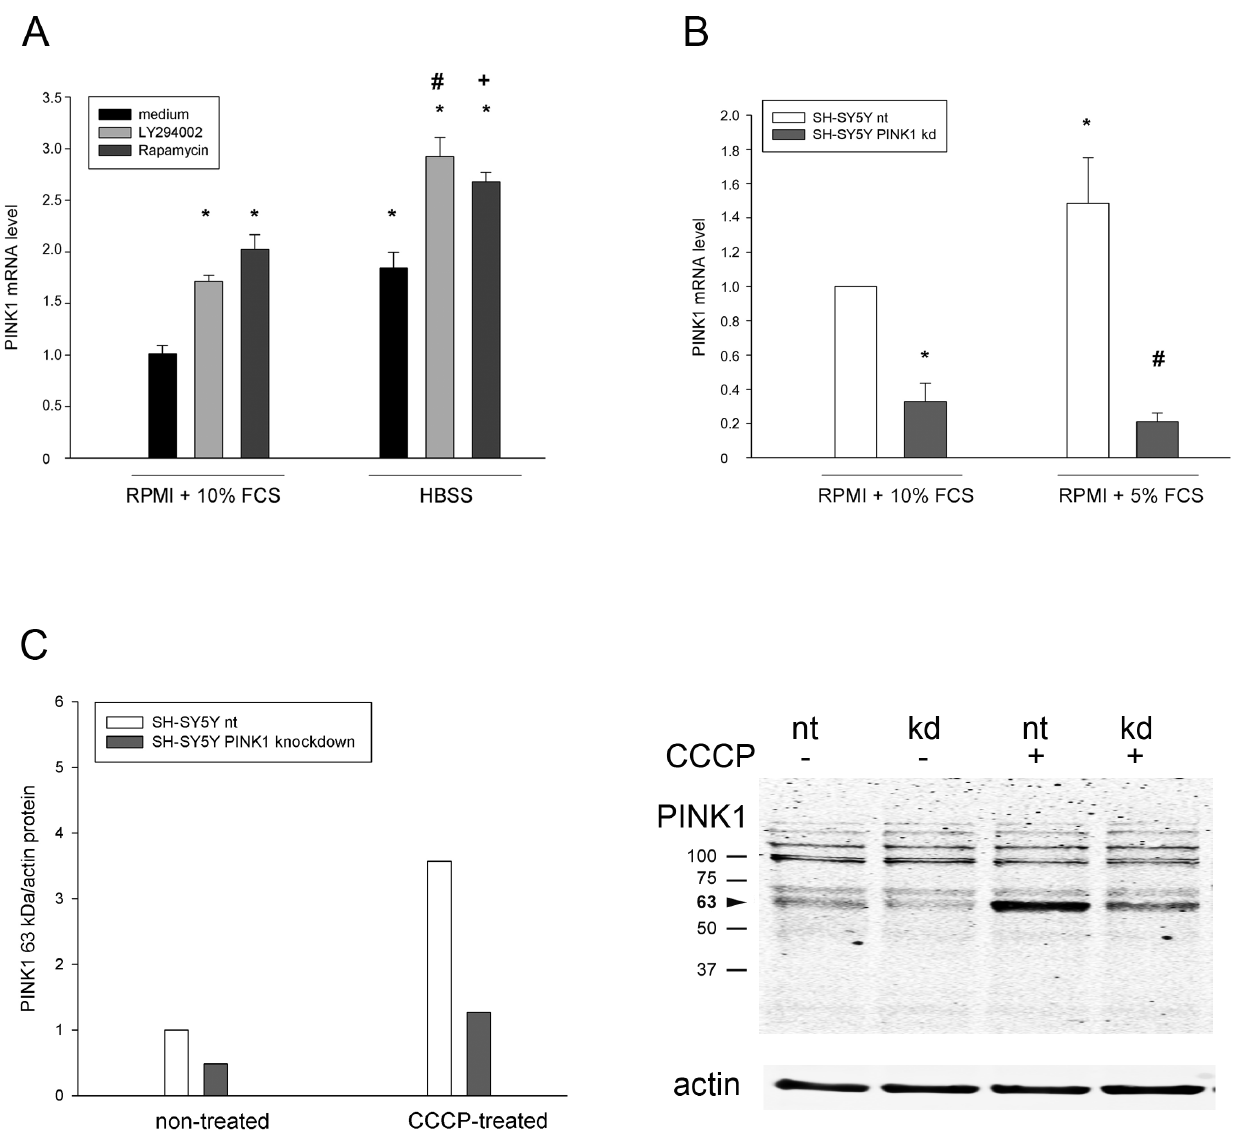
Figure 1. Stable PINK1 knockdown in SH-SY5Y cells. A) SH-SY5Y neuroblastoma cells were either cultivated in RPMI + 10% FCS or starved in HBSS with or without addition of LY294002 or rapamycin. After 16 h PINK1 mRNA expression was determined by RT-qPCR and the PINK1 mRNA content of cells kept in RPMI + 10% FCS was set as 1. Induction of autophagy by starvation or rapamycin resulted in an induction of PINK1 expression, comparable to the positive control LY294002; n=4; * expression changes compared to the PINK1 expression in RPMI + 10% FCS: LY294002: p , 0.01; rapamycin: p , 1 6 10 2 4 ; HBSS: p , 0.005; HBSS + LY294002: p , 5 6 10 2 6 ; HBSS + rapamycin: p , 0.0005; # expression changes compared to the PINK1 expression in RPMI + 10% FCS + LY294002: p , 0.05; + expression changes compared to the PINK1 expression in RPMI + 10% FCS + rapamycin: p , 0.0005. B) SH-SY5Y cells were either stably transduced with a control (nt) shRNA or a shRNA directed against PINK1 and cultivated in RPMI medium containing 5% or 10% FCS. Their PINK1 mRNA content was determined by RT-qPCR and PINK1 mRNA content of nt cells kept in medium with 10% FCS was set as 1. Serum reduction increased PINK1 mRNA in nt cells in accordance with the data shown in Fig. 1A, while stable PINK1 knockdown (kd) reduced PINK1 content under both conditions; n=3; * expression changes compared to the PINK1 expression in RPMI + 10% FCS: PINK1 kd 10% FCS p , 0.0005; PINK1 induction by 5% FCS: p , 0.05; # expression changes compared to the PINK1 expression in RPMI + 5% FCS: PINK1 kd 5% FCS: p , 0.005. C) SH-SY5Y cells without (nt) or with stable PINK1 knockdown (kd) were kept in medium with 5% FCS and either untreated or treated for 2 h with CCCP to stabilize PINK1. Afterwards the PINK1 63 kDa protein (arrowhead) and actin protein levels were determined by western blotting (see representative gel on the right). The quantification revealed a reduction of PINK1 protein under both conditions in PINK1 kd cells.